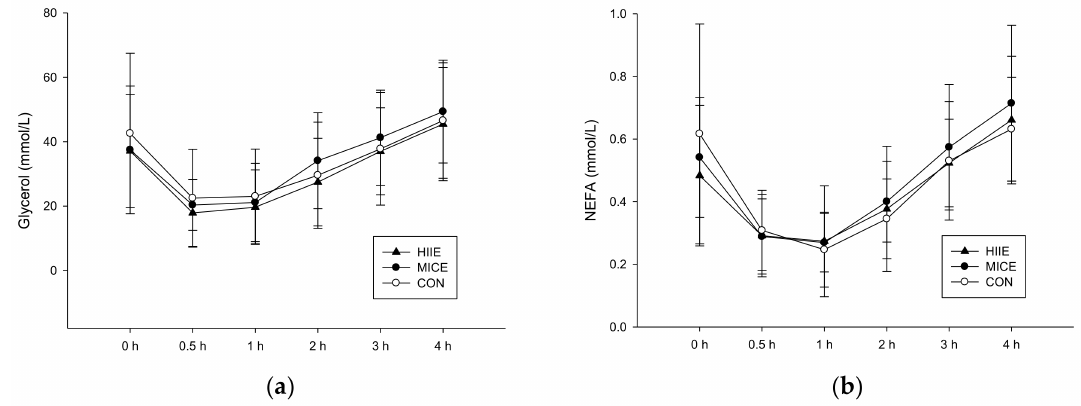
Figure 3. Plasma glycerol concentrations ( a ) and plasma NEFA concentrations ( b ) during the 4-h postprandial period. There were no significant differences between trials after a high fat